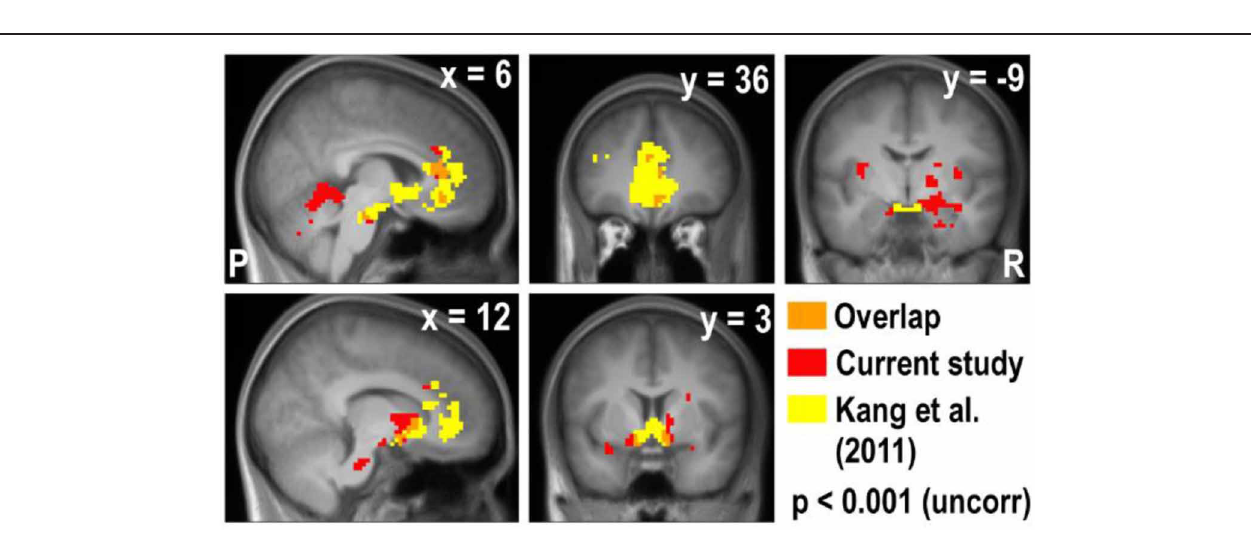
FIGURE A5 | Overlay of the deactivation map of the real × bid contrast and the activation map of the real × mDV contrast in Kang et al. (2011). The vmPFC, ACC, and striatum appear in both studies, but the amygdala only appears in the current study.